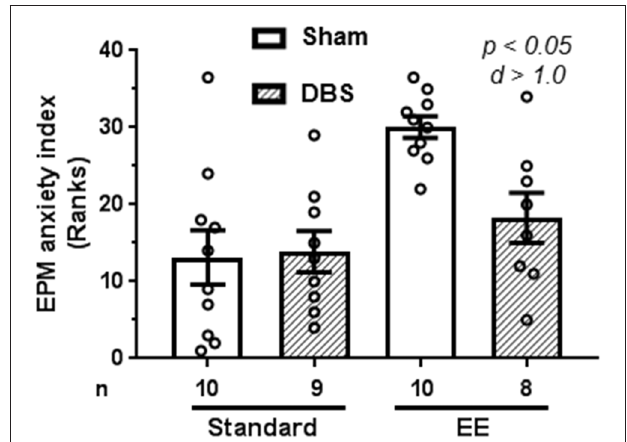
FIGURE 1 | Effects of deep brain stimulation (DBS) on latency to emerge from home-cage in presence or absence of enriched environment (EE). Emergence latency (in seconds) was rank-transformed for the illustration. Mean and SEM, along with individual rank of animals in each group, are depicted. Number of animals ( n ) is also presented. Both p and Cohen’s d values are shown for statistically significant comparisons between DBS and corresponding sham groups.